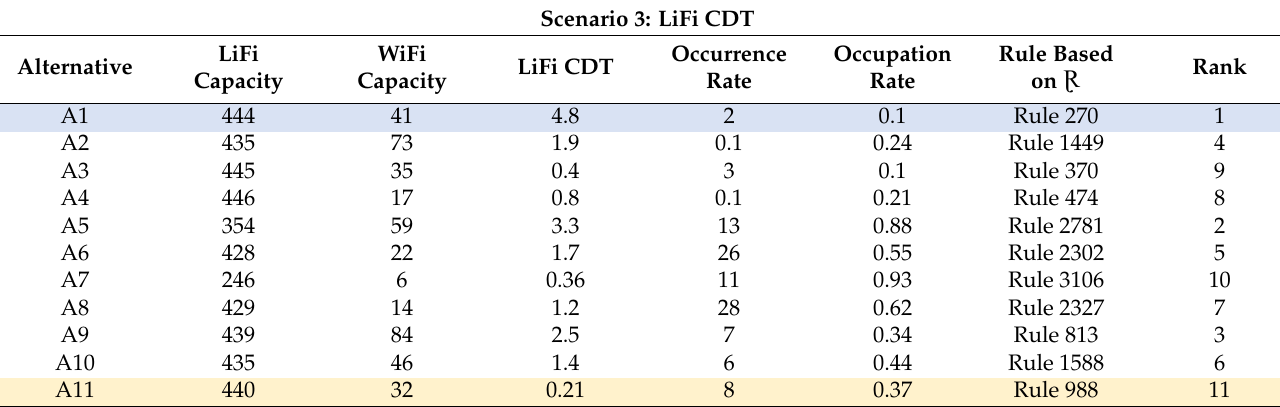
Table 11. Using Criteria #3 (LiFi CDT) for ranking the best and worst alternatives.